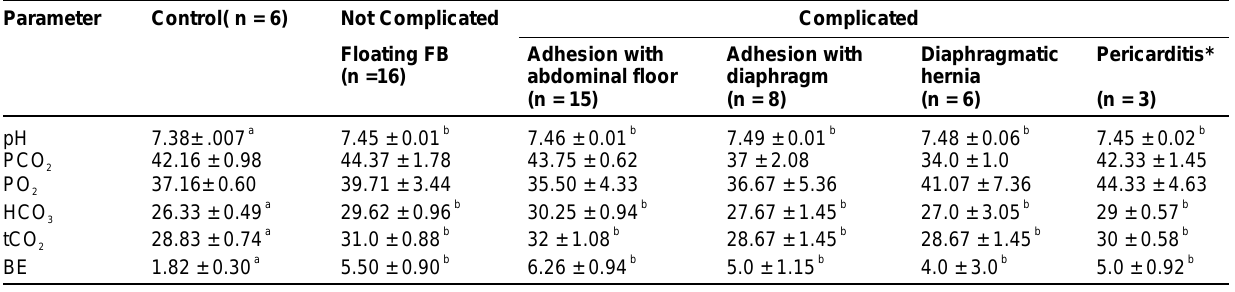
Table-1. Mean values (±SE) of blood gases and acid-base status in control and different conditions of SFBS in buffaloes Parameter